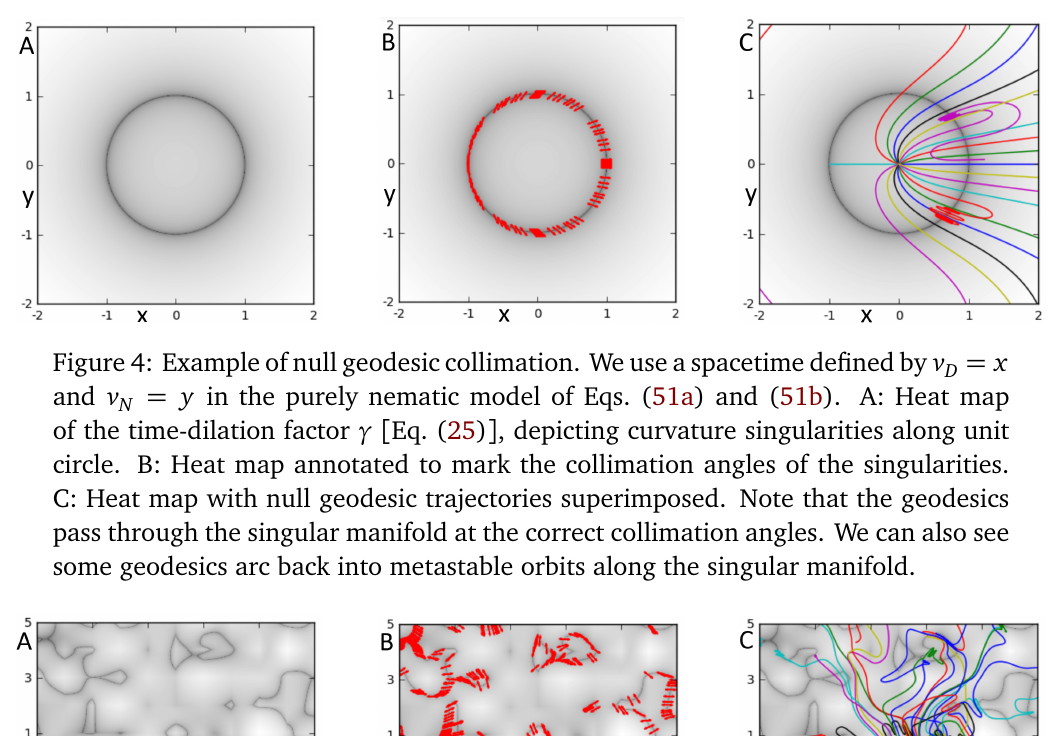
Figure 5: Example of null geodesic collimation in a random quenched gravitational disorder realization. We use the same manifold depicted in Fig. 1. A: Heat map of time-dilation factor γ [ Eq. (25) ] , depicting domain walls of singularities. B: Heat map annotated to mark the collimation angles of the singularities. C: Heat map with null geodesic trajectories superimposed. We see both that the geodesics pass through the singular manifold at the correct collimation angles, and that geodesics have a tendency to cross singular manifolds multiple